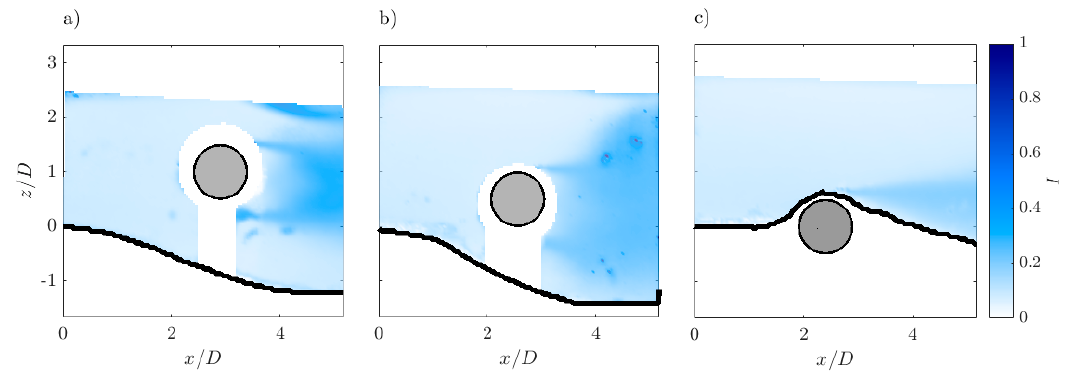
Figure 13. Ensemble-averaged turbulence level on a vertical plane in ( a ) Run 1, ( b ) Run 2 and ( c ) Run 3.